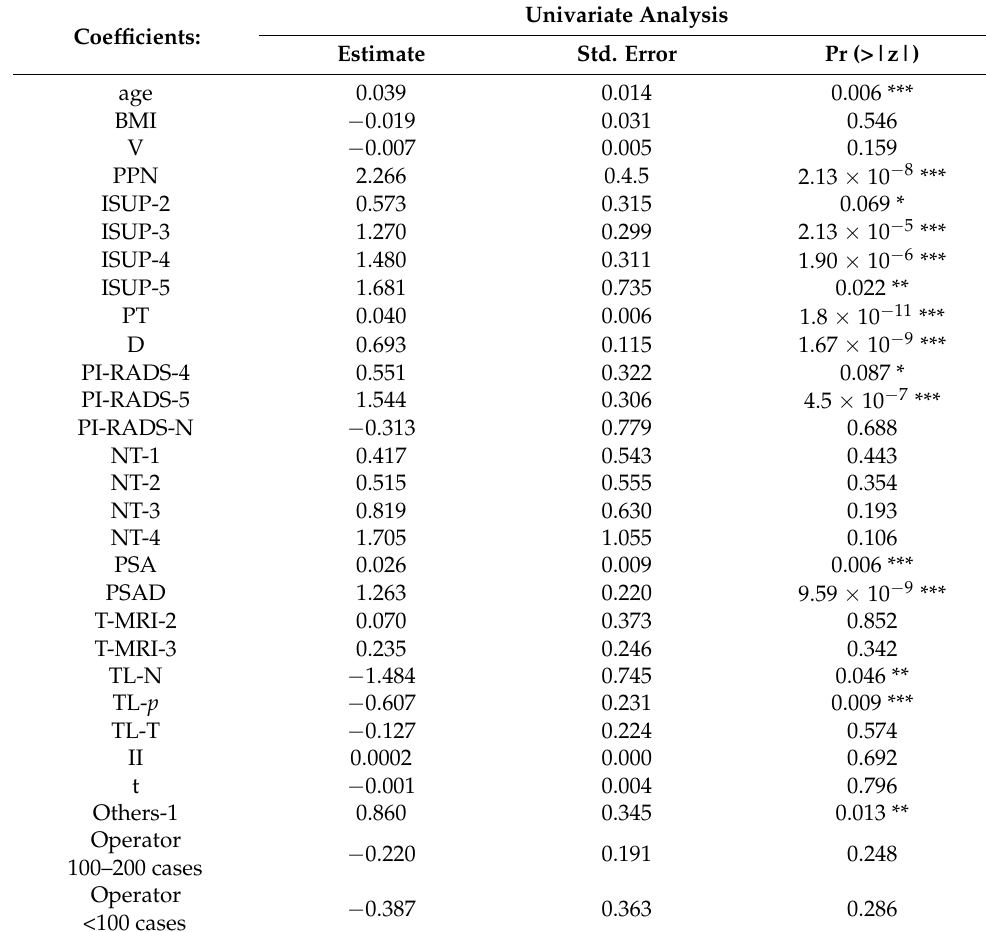
Table 2. Regression coefficients for univariate analysis.